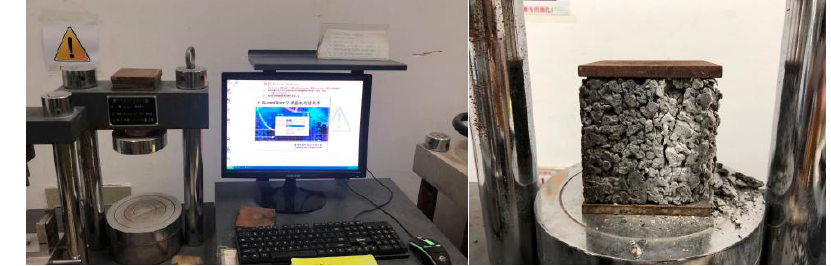
Figure 3. Compressive strength test.